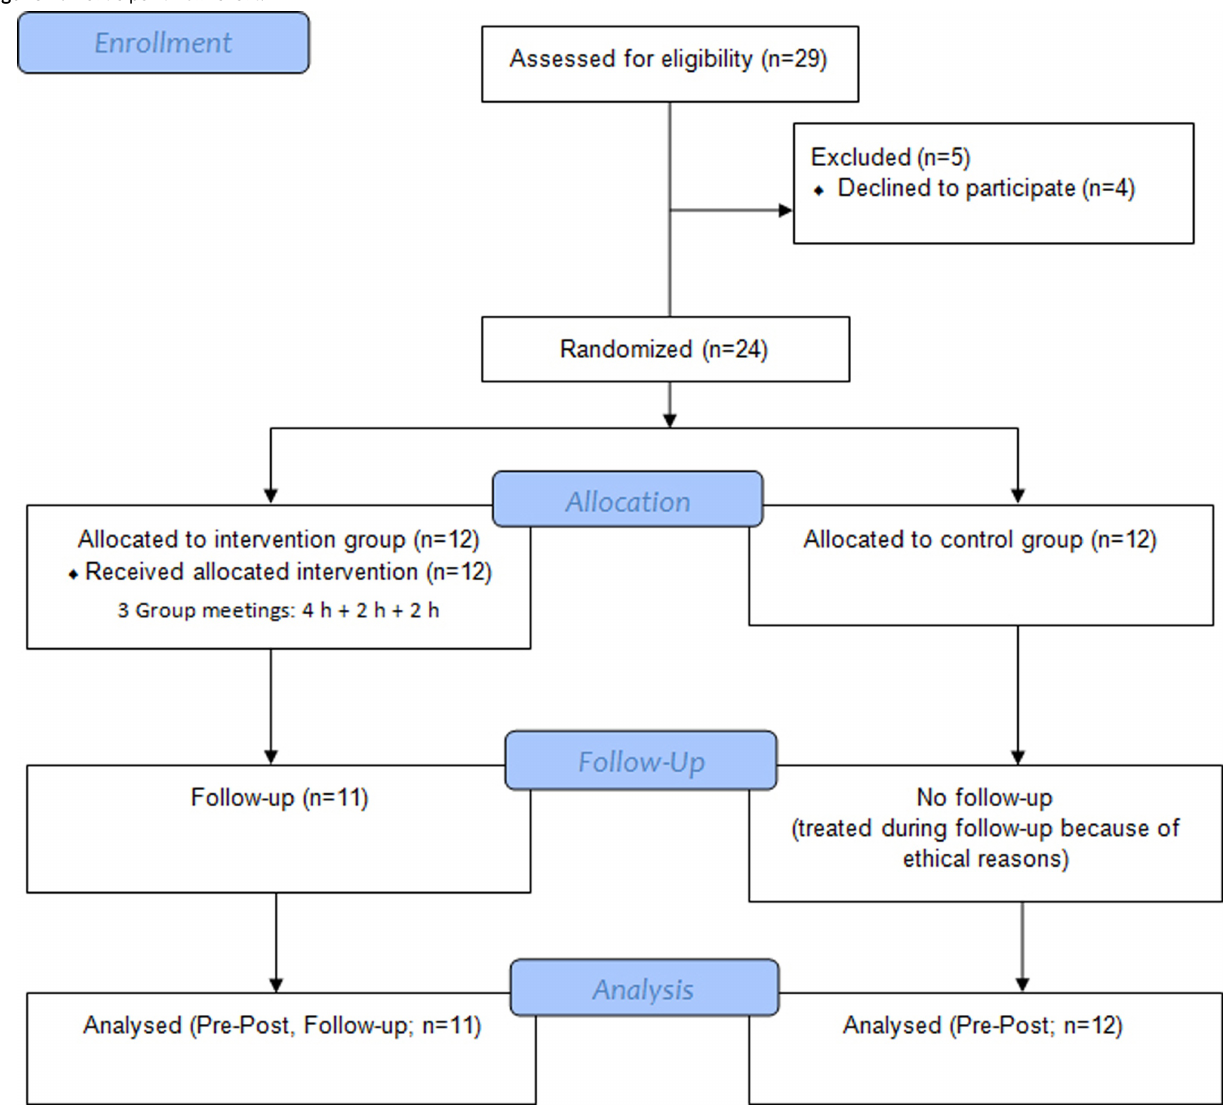
Figure 1. Participant flow chart.